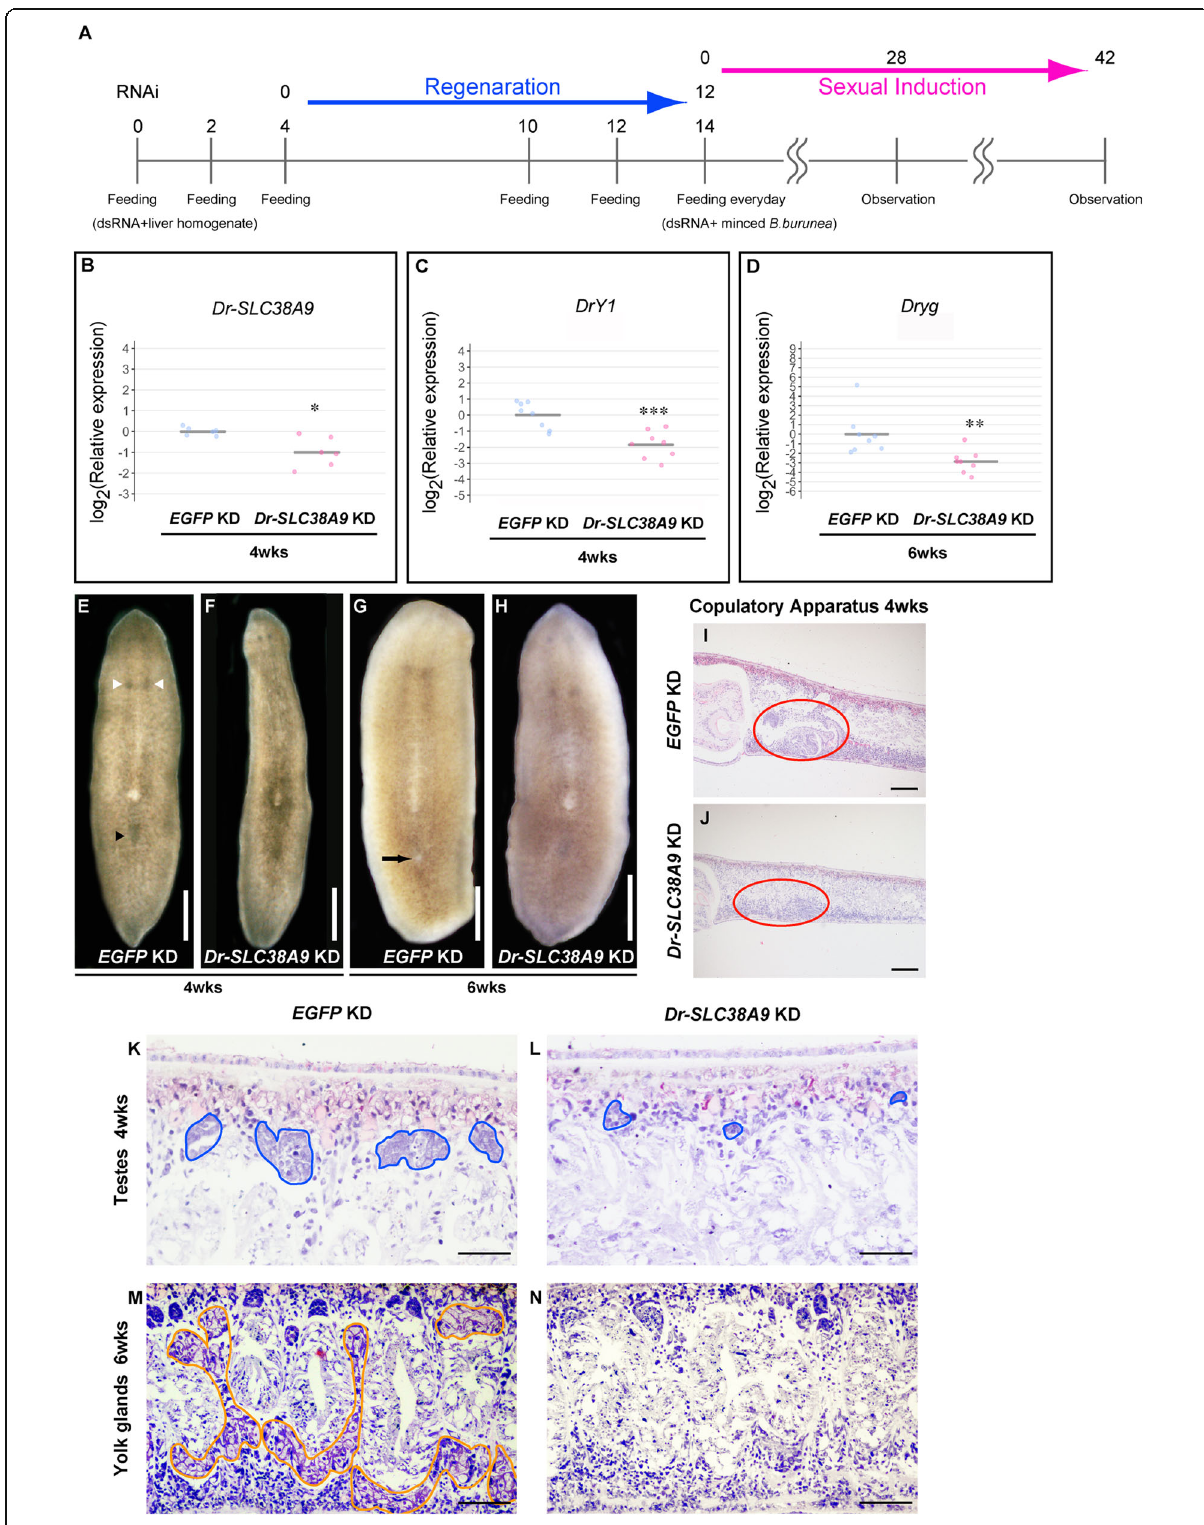
Fig. 4 (See legend on next